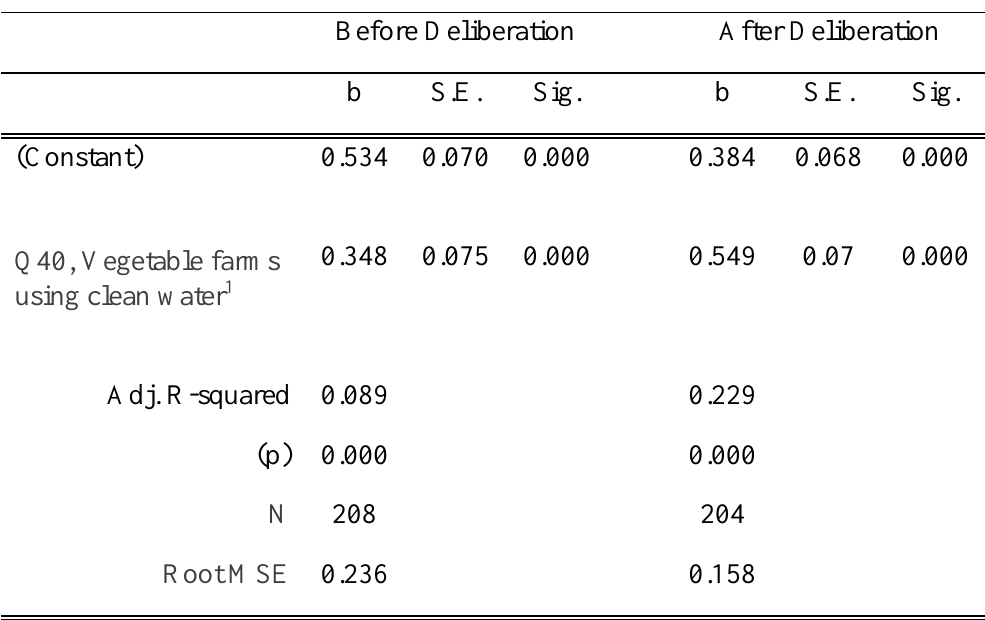
Table 4: Regression: Banning Waste